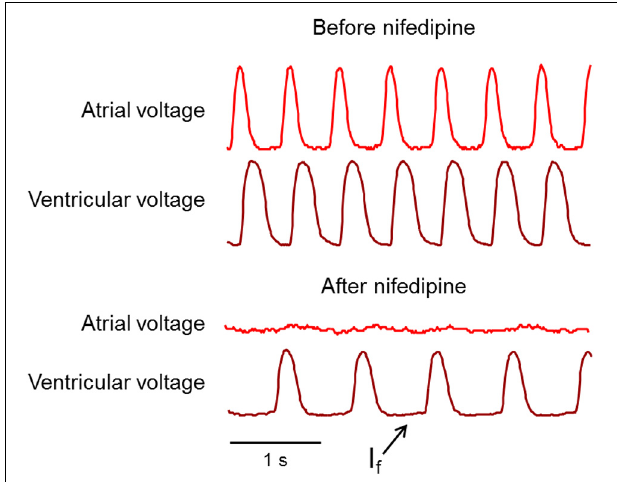
FIGURE 7 | Appearance of a ventricular funny current, I f , after nifedipine treatment. Top : Before nifedipine, ventricular voltage decreased during phase 4 of the AP. Bottom : After nifedipine ventricular voltage slightly increased during phase 4, indicating a transition to ventricular